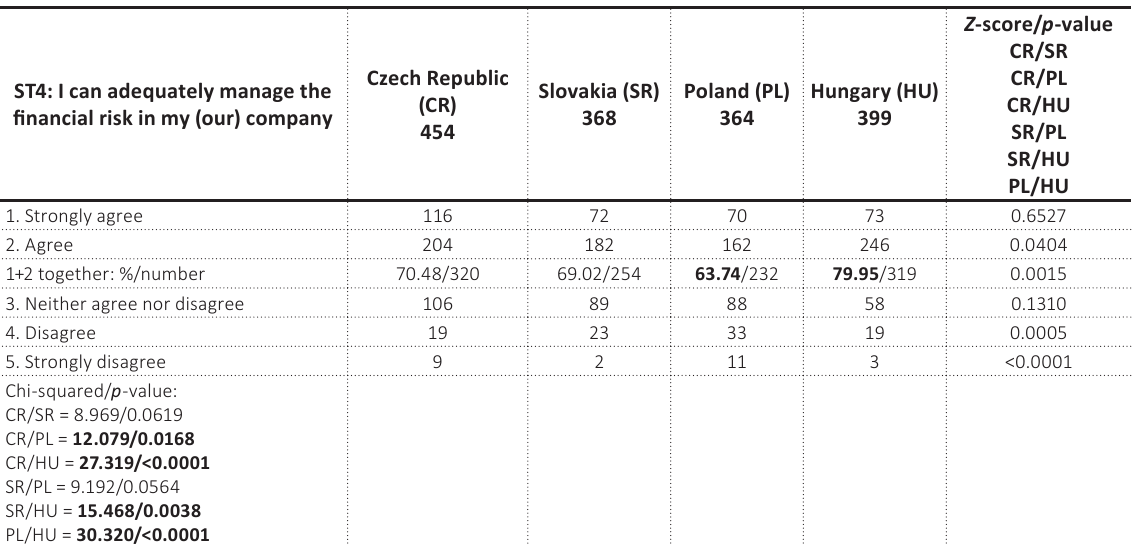
Table 4. Evaluation of own financial risk management skills in the V4 countries